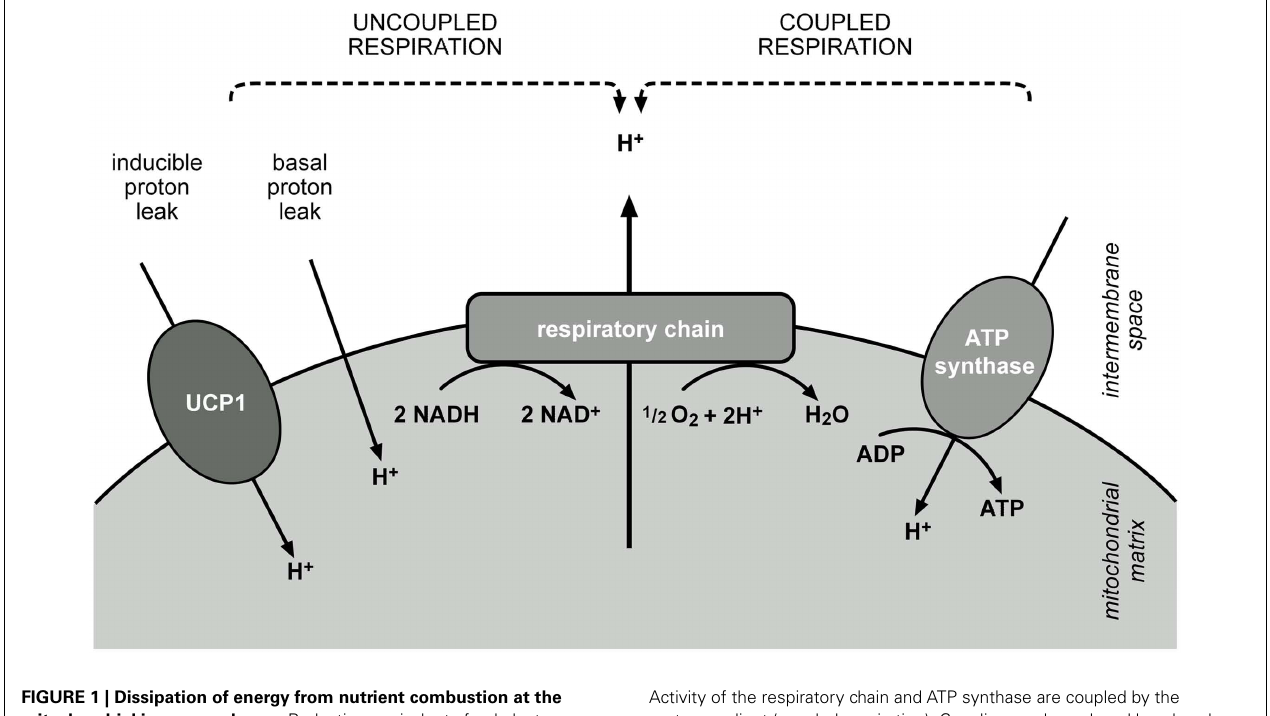
FIGURE 1 | Dissipation of energy from nutrient combustion at the mitochondrial inner membrane. Reduction equivalents feed electrons into the respiratory chain, which are passed along a redox gradient and reduce oxygen to water. Energy released by these reactions is stored as a proton gradient across the membrane, as protons are pumped into the intermembrane space. ATP synthase utilizes this energy and the flux of protons along the enzyme leads to the phosphorylation of ADP to ATP.